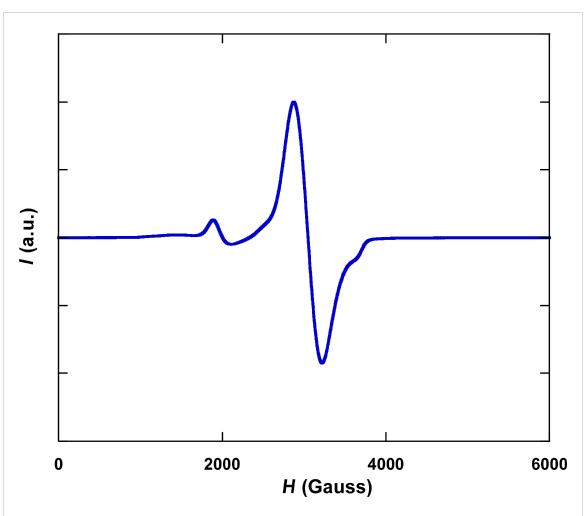
Figure 3: EMR spectrum at room temperature for the Fe 3 O 4 @OA sample measured in